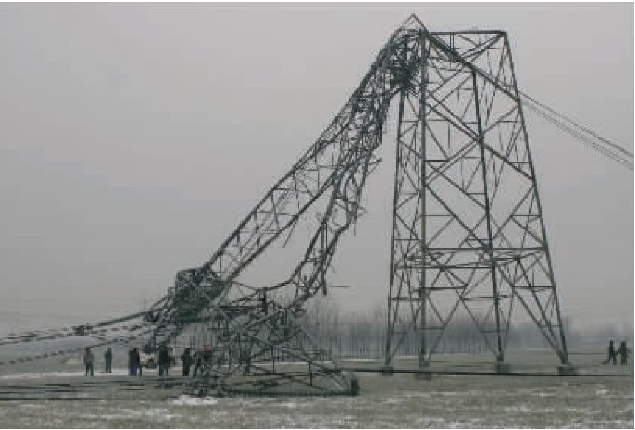
Figure 1. The collapse of the power grid tower was caused by the snow and icing disaster [10].